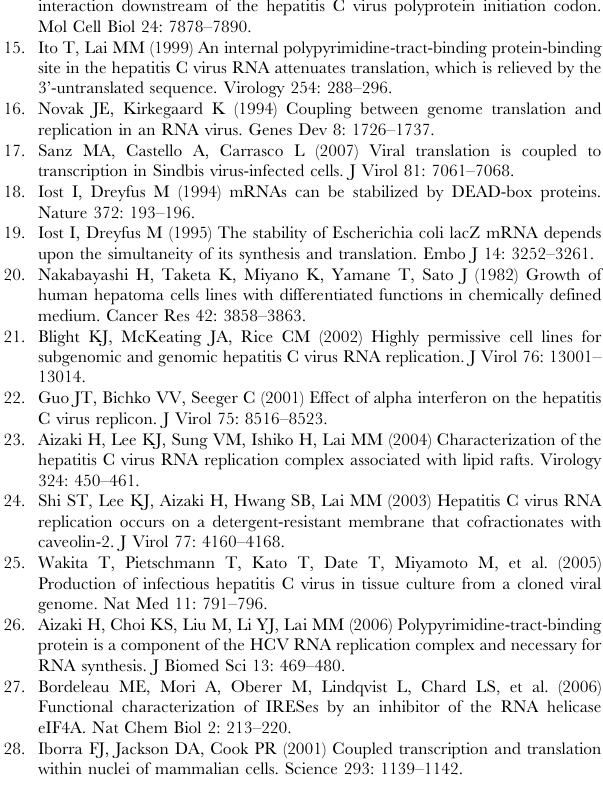
Figure S2 Preferential translation of JFH1 wildtype over the GND mutant HCV RNA. (A) A time-course study of HCV NS protein translation in cells transfected with JFH1 or its GND mutant. The cells were labeled with S 35 -methionine from 0–8, 8– 16 and 16–24 hours posttransfection and followed by immuno- precipitation with anti-NS3 or HCV patient serum. NS3 and NS5A were detected by immunoprecipitation and separated by SDS-PAGE. (B) The corresponding intracellular HCV RNA levels in (A). The intracellular RNA levels at 24 hour post-transfection were determined by real-time